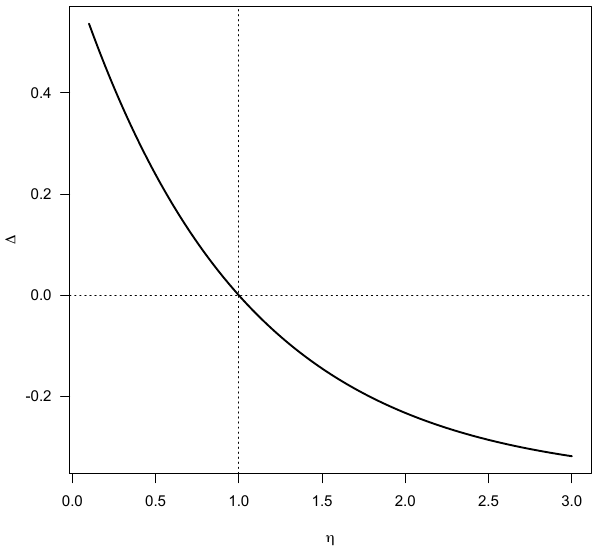
Fig. 3. Relationship between η (proportional change in temperature variance) and ∆ (difference in average respiration) for an exponen- tial function R = exp( T ) .